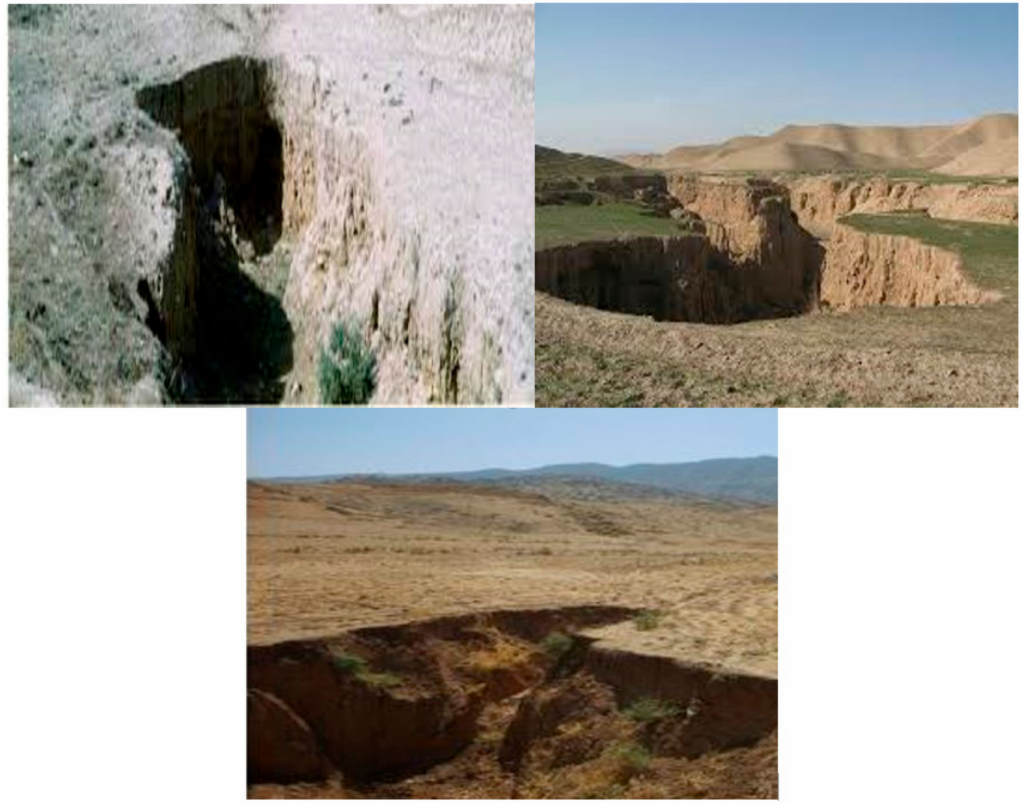
Figure 2. Some photographs of the gully erosion zoned on study